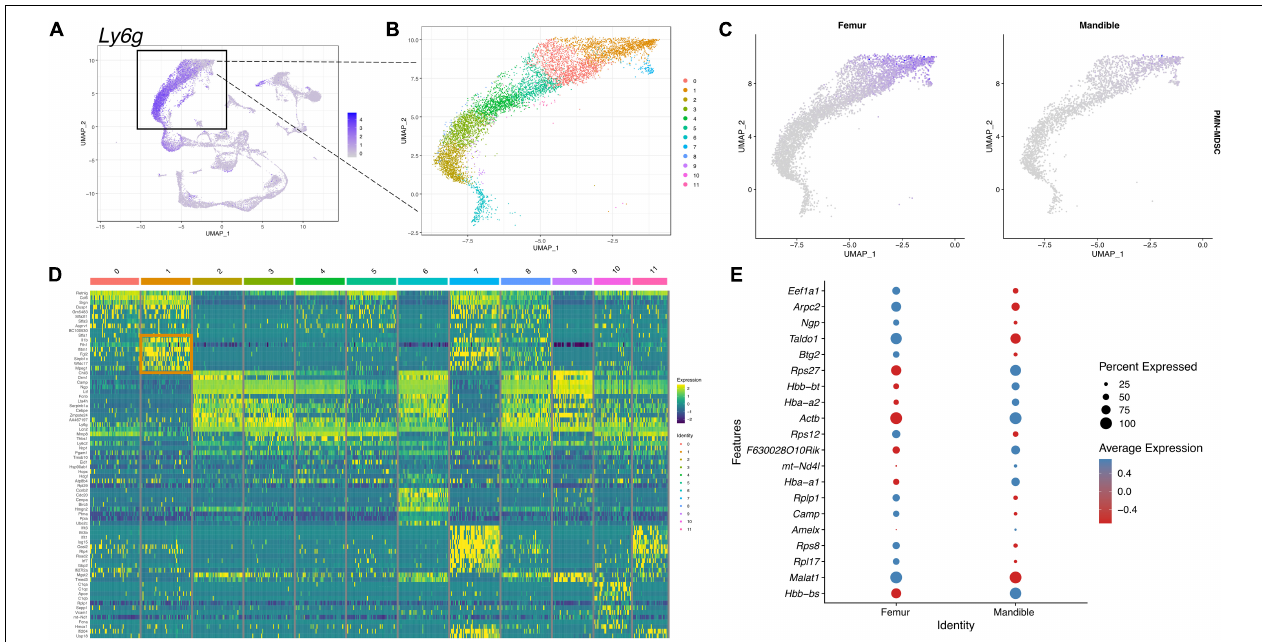
FIGURE 8 | scRNA-seq of PMN-MDSCs in mBM reveals transcriptional profile distinct from PMN-MDSCs in fBM. (A) To identify PMN-MDSCs, the neutrophil cluster marked by Ly6g expression (B) was divided into 12 clusters. (C) A feature map of the PMN-MDSC composite genes show cluster 1 is enriched for PMN-MDSC genes. (D) Heatmap of the top 10 most highly expressed genes in each cluster. PMN-MDSC genes from cluster 1 are boxed in orange. (E) The top 20 differentially expressed genes in cluster 1 between femur and mandible displayed in a dotplot, showing PMN-MDSC specific transcriptomic